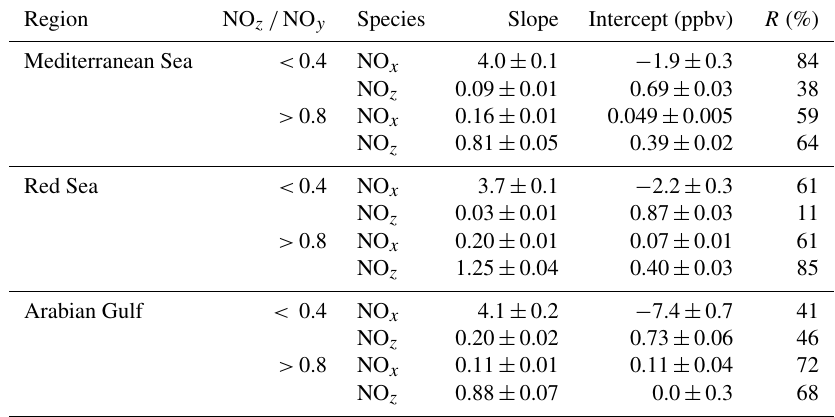
Table 2. Summary of correlation results between NO x / NO z and SO 2 in all regions. Region NO z / NO y Species